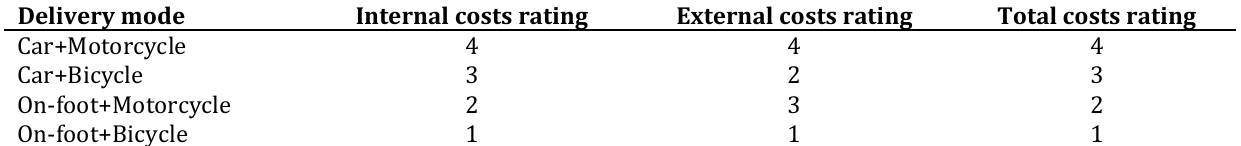
Table 14: Rating of internal, external and total costs of different combination of means of urban delivery in bad weather conditions Delivery mode Internal costs